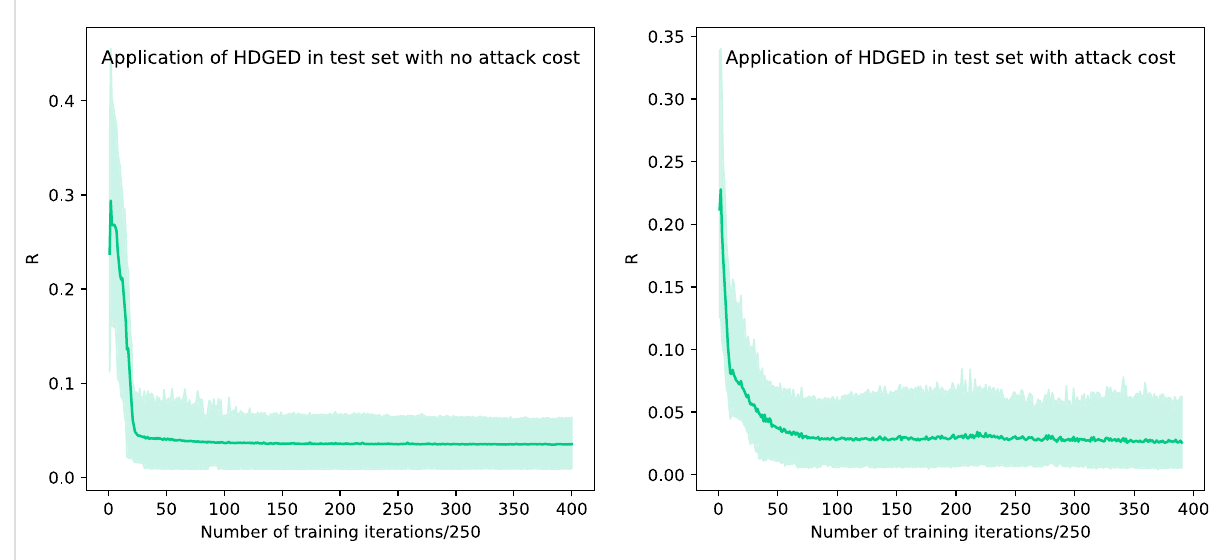
FIGURE 9 The performance of HDGED on the test set under two scenarios as the training progresses. The reward function is represented by the R